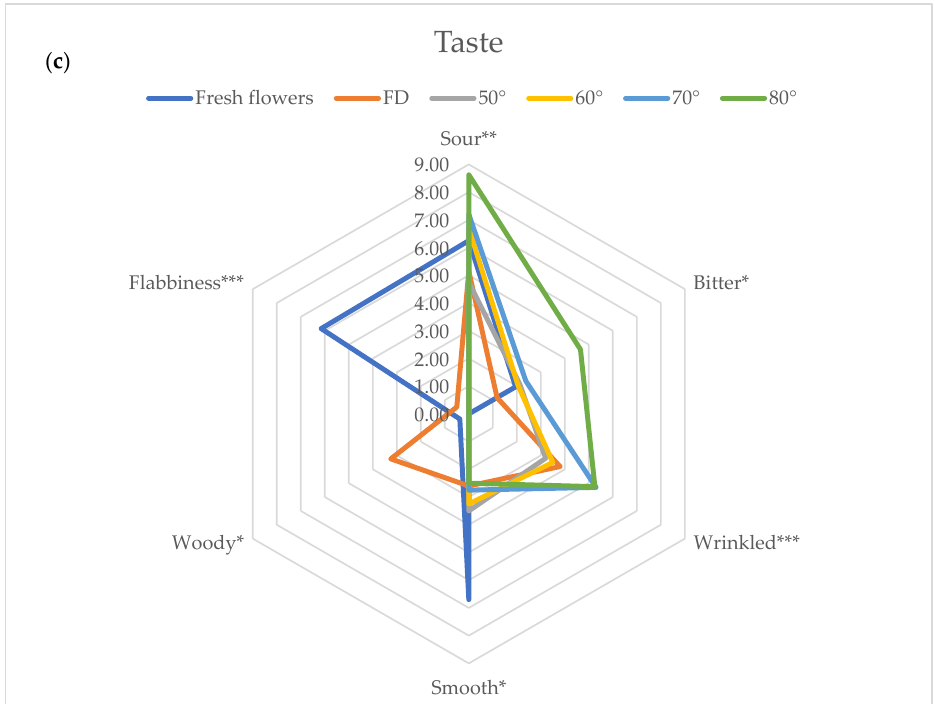
Figure 3. Flowers’ sensory profile related to View ( a ), Smell ( b ) and Taste ( c ). The figures only report the parameters that showed statistically significant differences. Significance level *** p < 0.001, ** p < 0.01; * p < 0.05. Abbreviation: FD — freeze-dried.